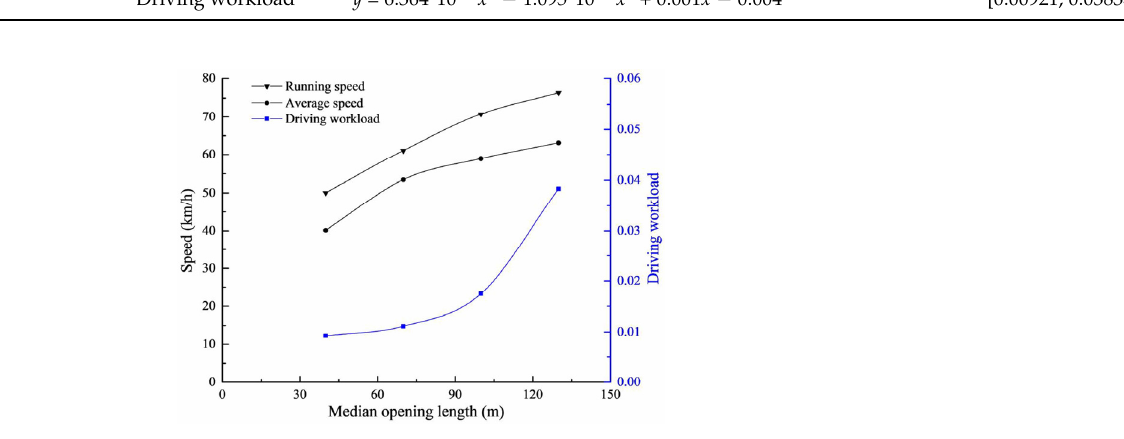
Figure 10. Fitting curve of different opening lengths with vehicle speed and driving workload in the work zone. Table 7. Fitting results of different opening lengths with vehicle speed and driving workload in the work zone.